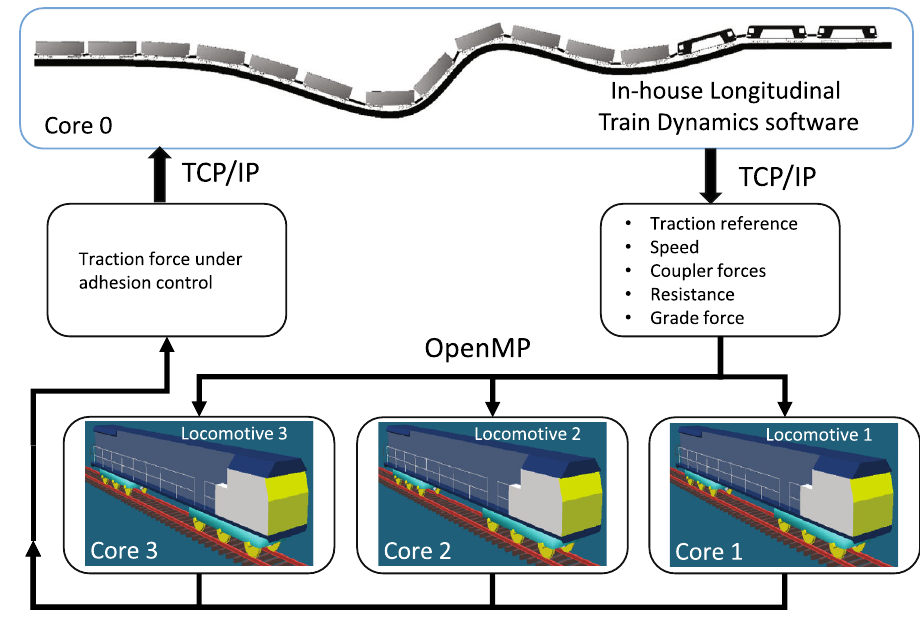
Fig. 5 Simulation strategy for 3D locomotive and LTD